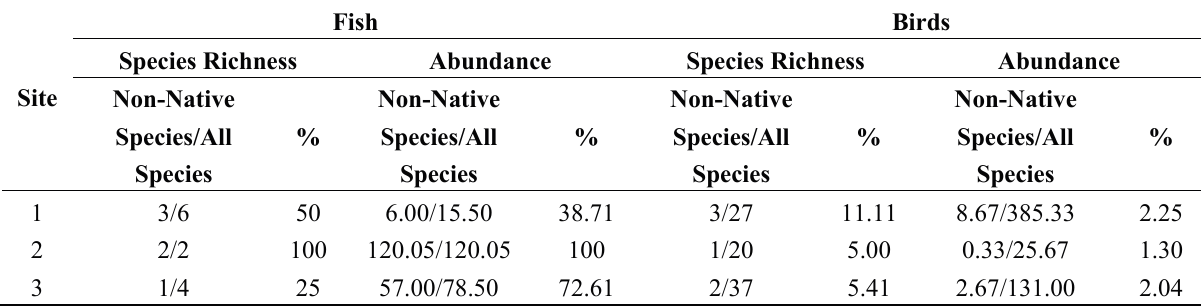
Table 2. Relative species richness and abundance of non-native fish and bird species in our three study urbanized wetlands.